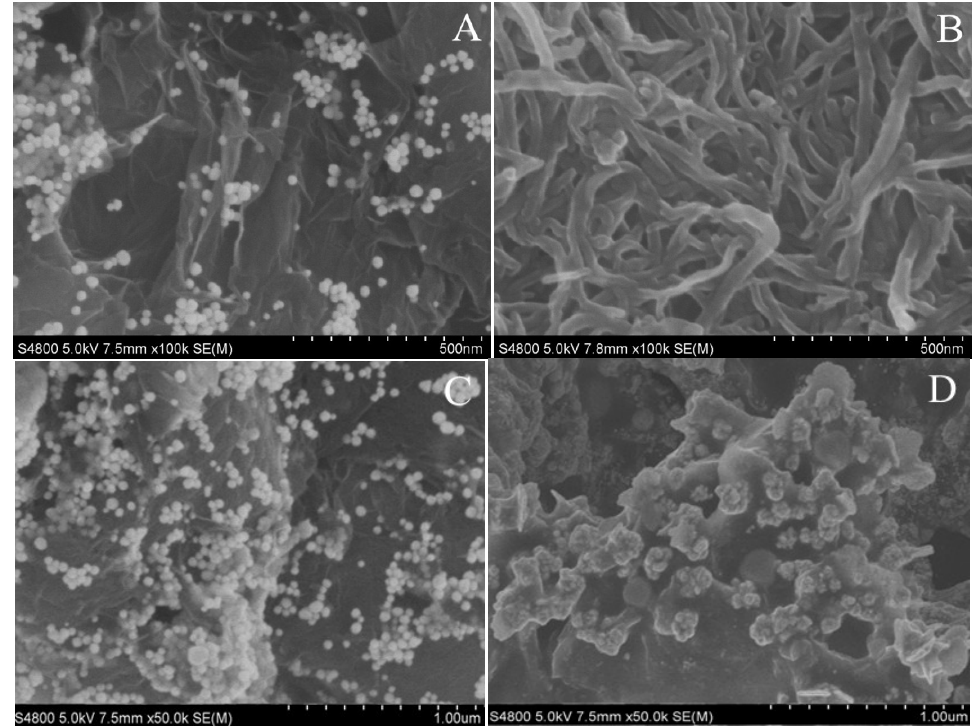
Figure 3. The SEM images of ( A ) GS-PEI-Au nanocomposites; ( B ) MWCNTs/GCE;